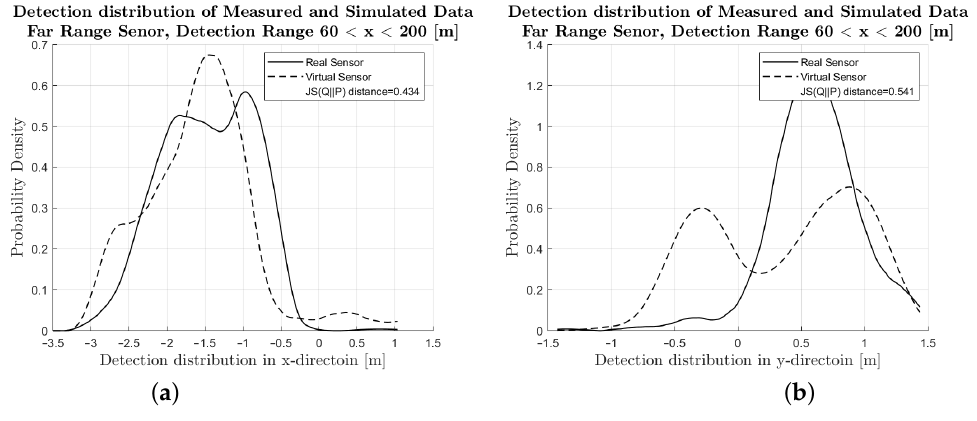
Figure A1. Evaluation of the detections in the range of 60 to 200 m of the far-range radar sensor and sensor model. ( a ) Scatterplot of the real sensor detections. ( b ) Scatterplot of the sensor model detections.